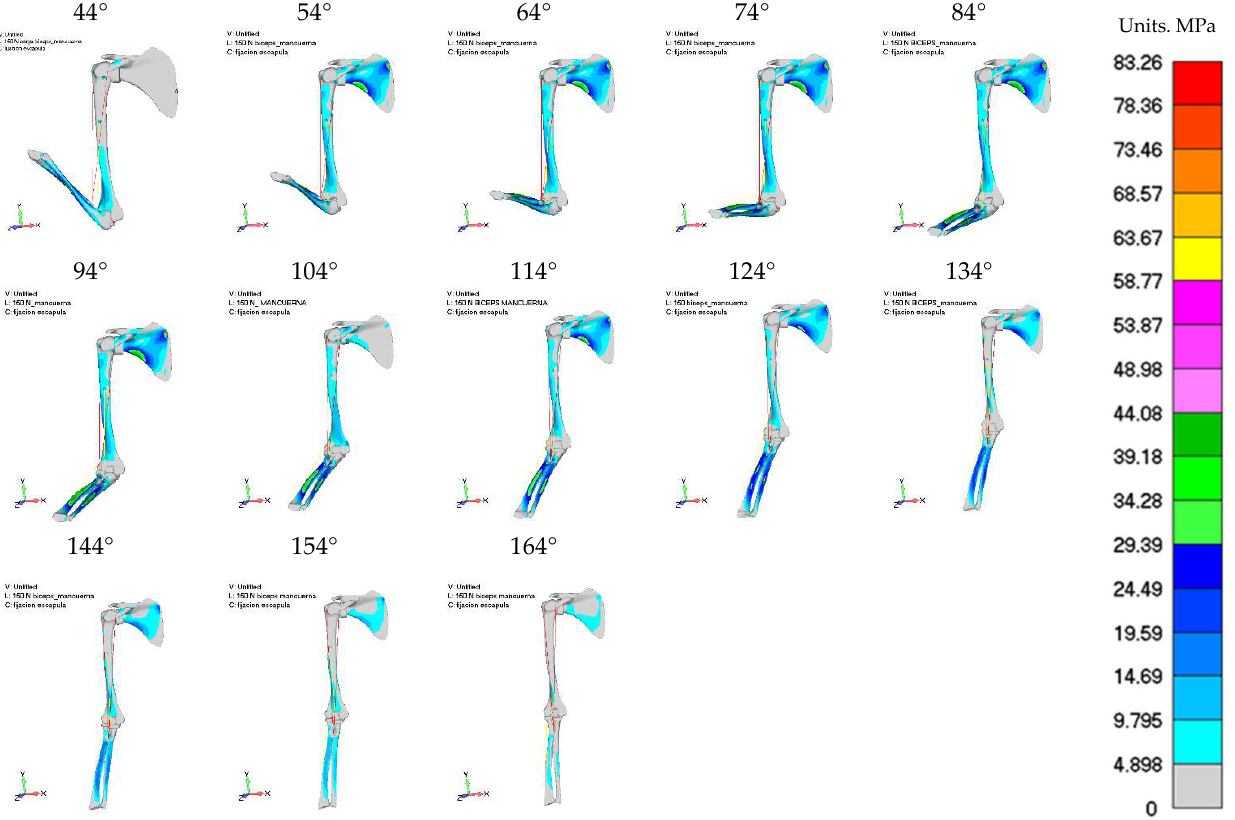
Figure 11. Different elbow angle configuration: bone Von Mises stress distribution under biceps loading (150 N on wrist) cases. Figures are included in more quality in Appendix A.